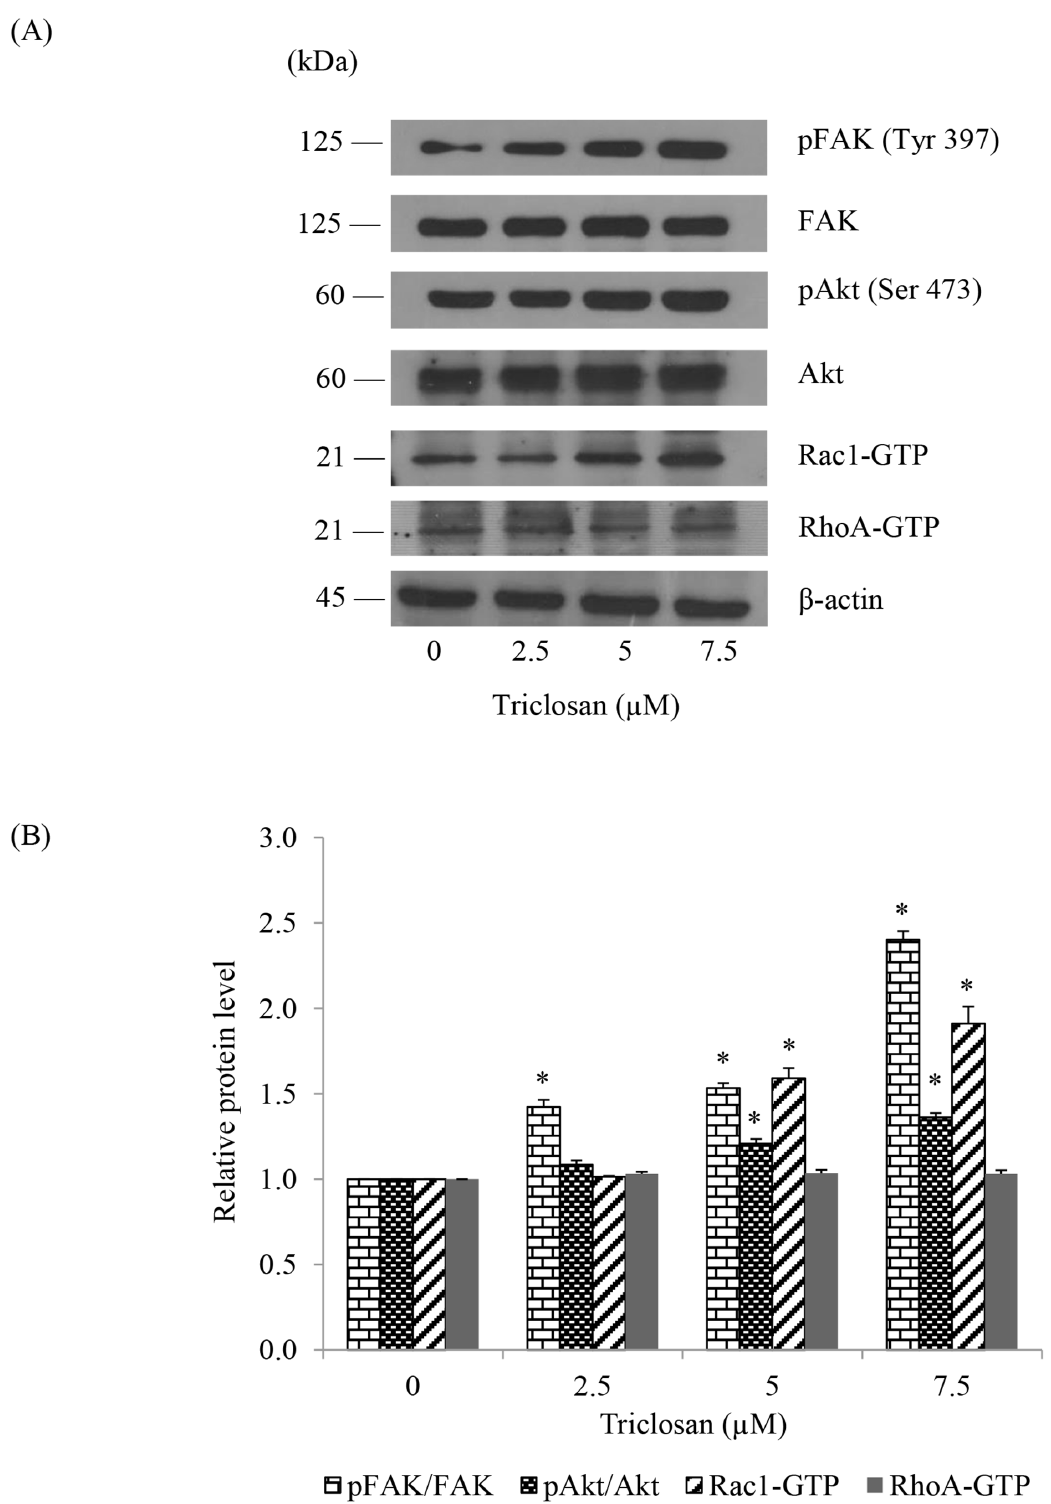
Figure 6. Effects of TCS-mediated EMT on migratory-related proteins. (A) Anoikis resistant H460 cells were treated with TCS at 0–7.5 m M for 24 h in detached condition and then attached on conventional culture dishes for 4 h. The level of pFAK (Tyr 397), FAK, pAkt (Ser 473), Akt, activated Rac1 (Rac1-GTP) and activated RhoA (RhoA-GTP) were determined by western blotting. Blots were reprobed with b -actin to confirm equal loading. (B) The immunoblot signals were quantified by densitometry and mean data from independent experiments were normalized to the results. Values are means of the three triplicate independent samples 6 SE. * P , 0.05 versus non-treated control.